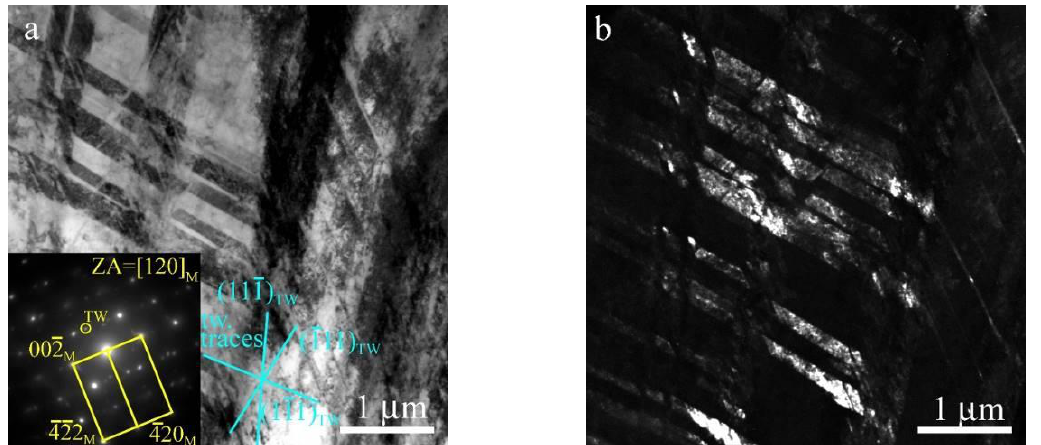
Figure 4. Bright-field ( a ) and dark-field ( b ) TEM images of the microstructure in specimens subjected to HPT 23 -processing followed by annealing at temperature 400 °C. SAED pattern in ( a )